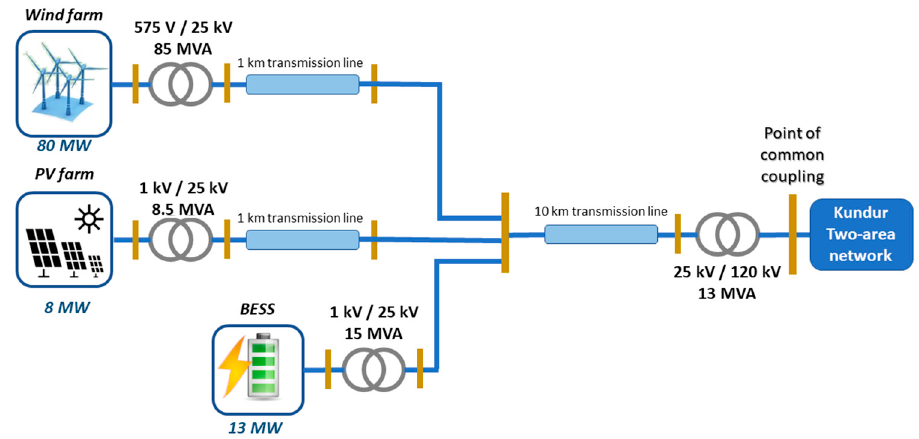
Figure 5. Single line diagram of the HPP and its connection to power network.